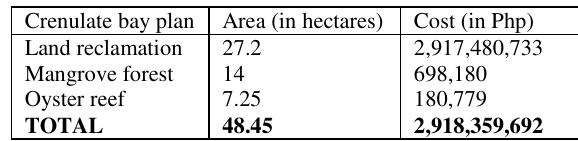
Table 2 . Estimated figures for implementing the crenulate bay plan.